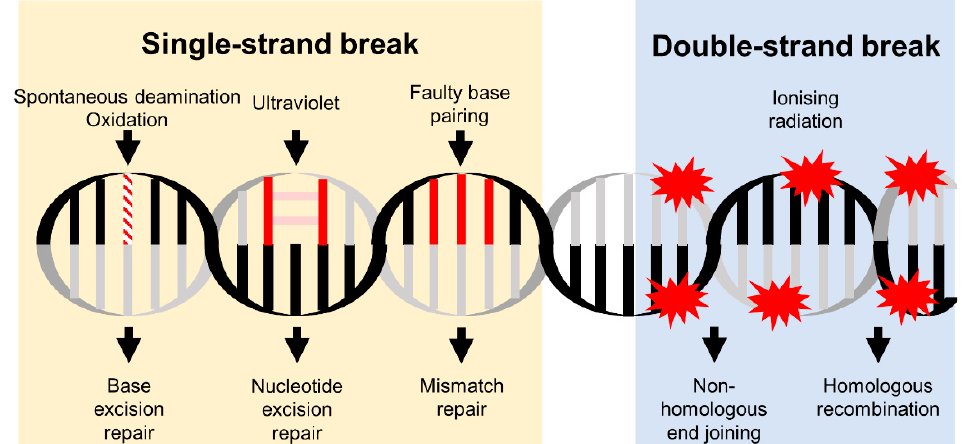
Figure 1. Main causes and repair mechanisms of DNA single-strand and double-strand breaks. Various endogenous or exogenous factors can damage DNA. Consequently, the DDR utilizes multiple pathways to repair different forms of DNA lesions.